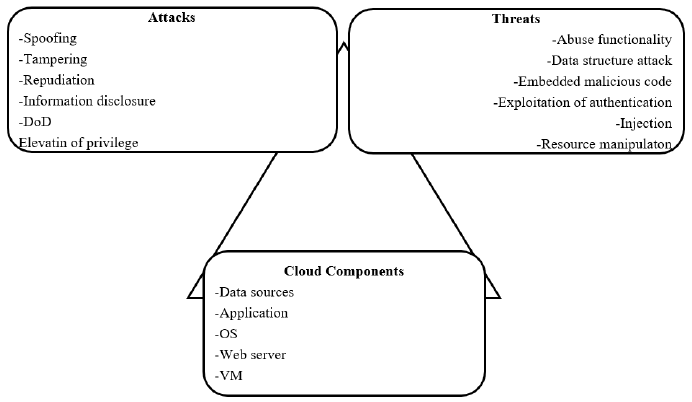
Figure 6. Attacks, threads, and components on cloud. Table 4. Summary and characteristics of IoT-based cloud